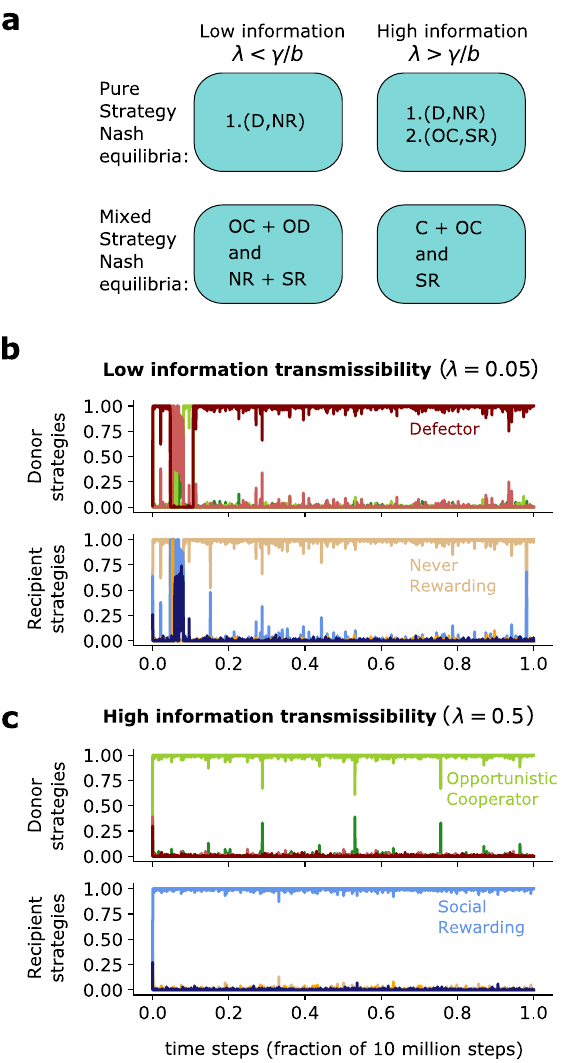
Fig. 2 | Reputation effects facilitate the co-evolution of social rewarding and cooperation. a To analyze the possible outcomes of the two-player game, we fi rst describe all its Nash equilibria. This analysis shows that full cooperation can be sustained if λ > γ / b , such that socially rewarding recipients have suf fi cient oppor- tunities to build up a reputation. b , c We expand on these static predictions by implementing evolutionary simulations for low and high information transmissi- bility. A low information transmissibility results in a population of non-rewarding defectors. A high information transmissibility results in a population in which